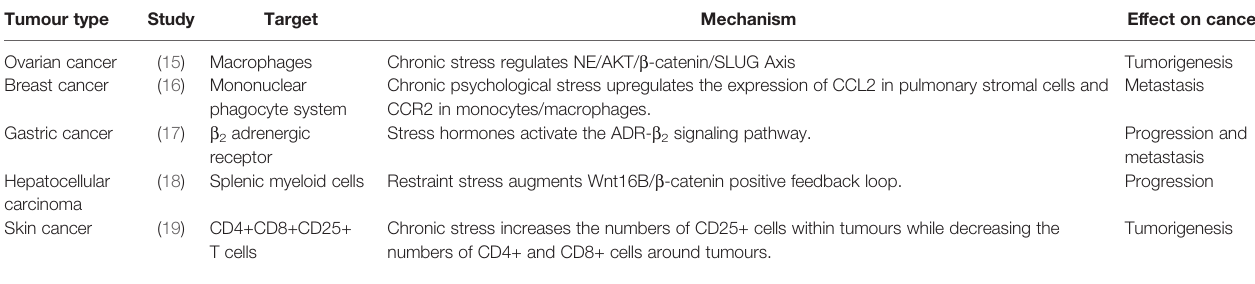
TABLE 1 | Published articles on chronic stress promoting tumorigenesis and